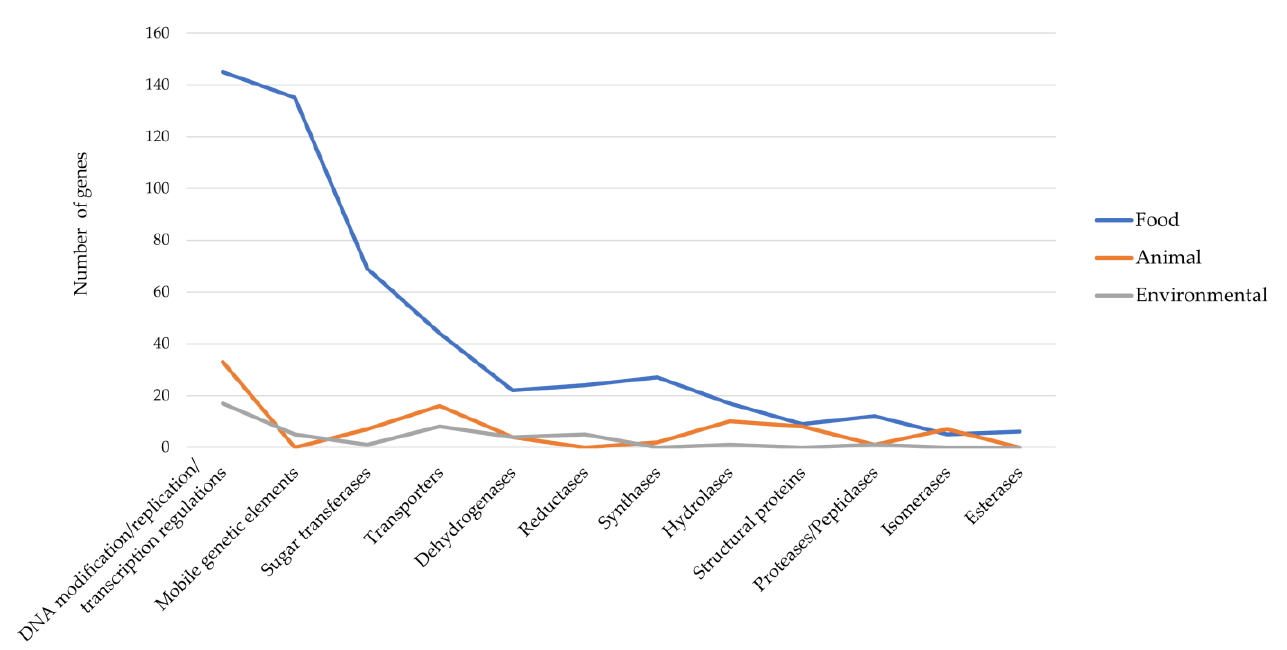
Figure 3. Main categories of genes found within the unique gene cluster present in each strain for the three different ecological niches investigated.